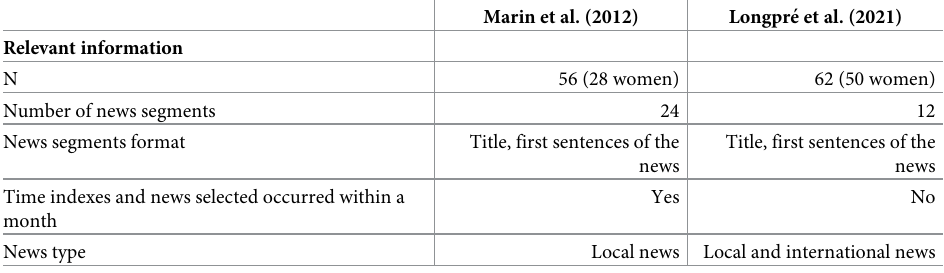
Table 1. Comparative table between Marin et al. (2012) and the current study.